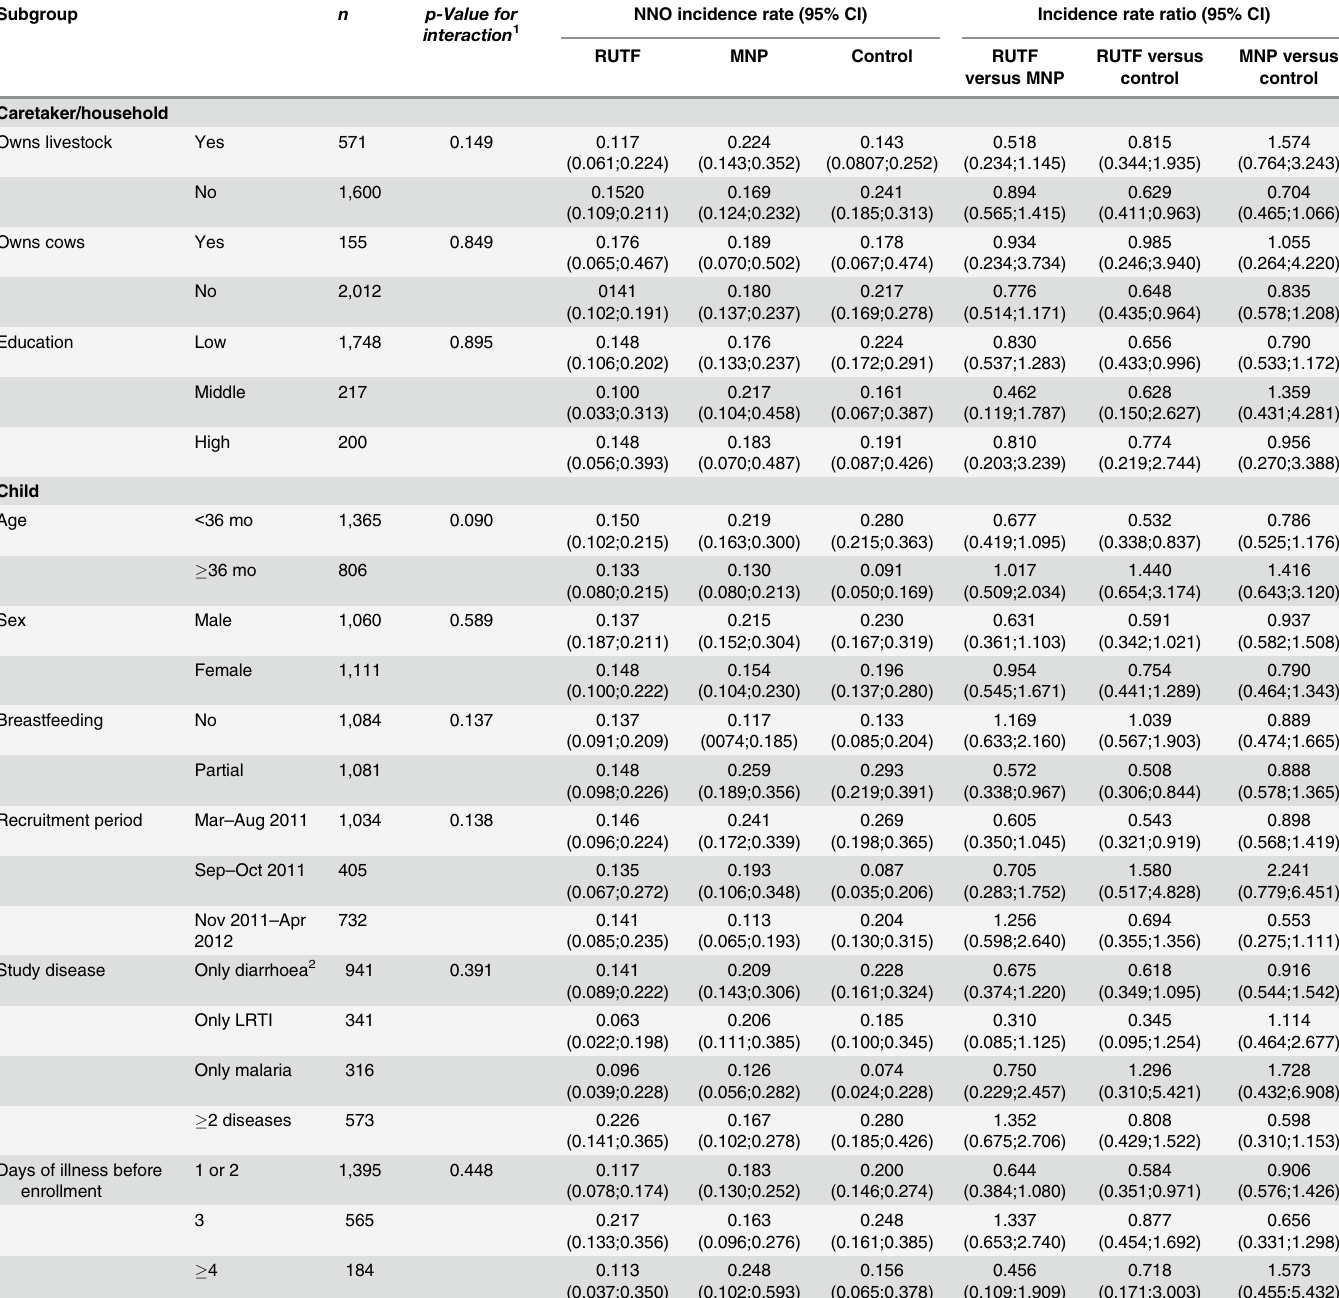
Table 4. Incidence rate of first NNO per y by